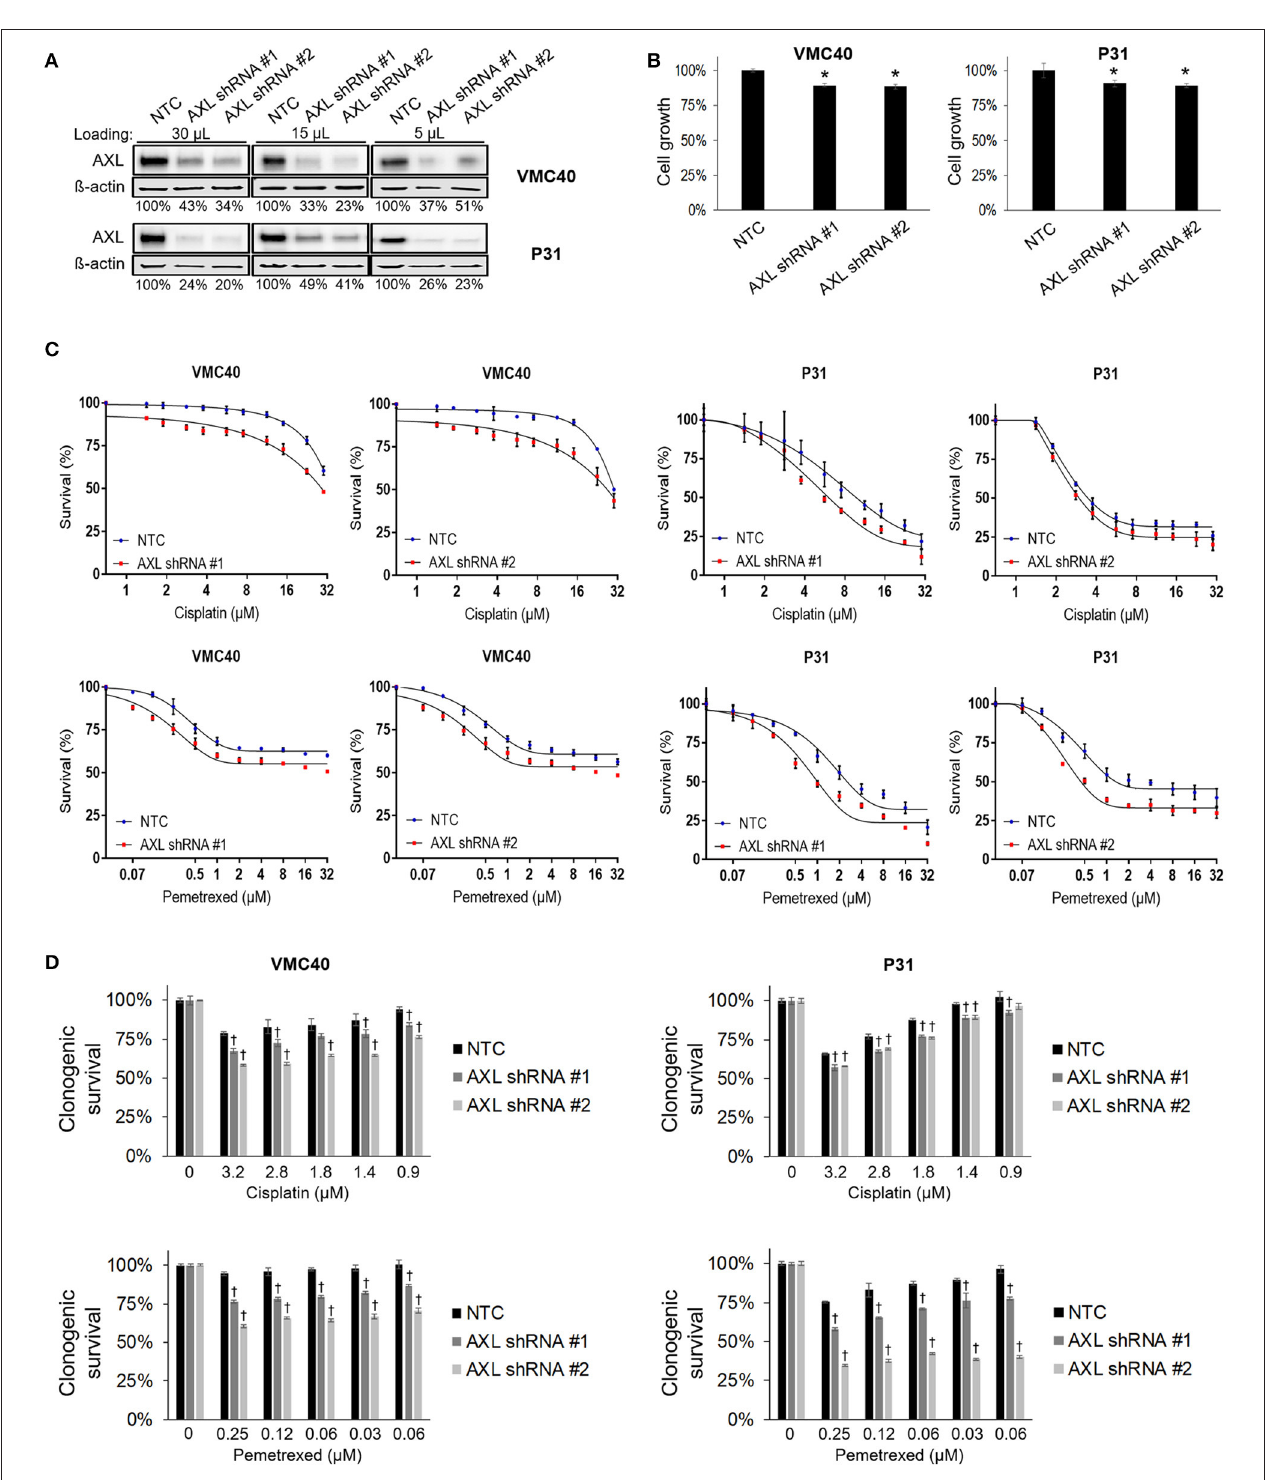
FIGURE 4 | AXL knockdown enhances cisplatin and pemetrexed efficacy. (A) Relative quantification of AXL after shRNA AXL knockdown using three gel loading volumes of 5, 15, and 30 µ L. Values are percentage of NTC. (B) Cell proliferation via SRB assay, values compared as percentage to NTC after 4 days of plating equal cell numbers. *Denotes p < 0.05 via t -test for value compared to NTC value. (C) Cell survival percentages by SRB assay after 72h treatment with cisplatin (top) and pemetrexed (bottom) at incrementing concentrations. (D) Cell survival percentages by clonogenic assay after 72h treatment with cisplatin (top) and pemetrexed (bottom) at incrementing concentrations. Values are relative to no drug treatment (100% for both NTC and AXL shRNA). † Denotes p < 0.05 via t -test for value compared to NTC value at the same concentration. Error bars represent ± SEM of three experiments (B-D).